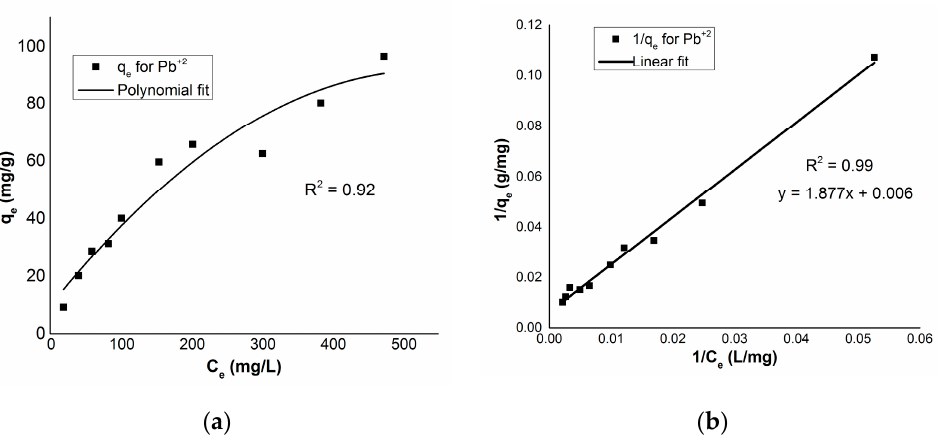
Figure 5. ( a ) Equilibrium sorption curve for Pb +2 and ( b ) adsorption isotherm curve, established for Pb +2 using Langmuir